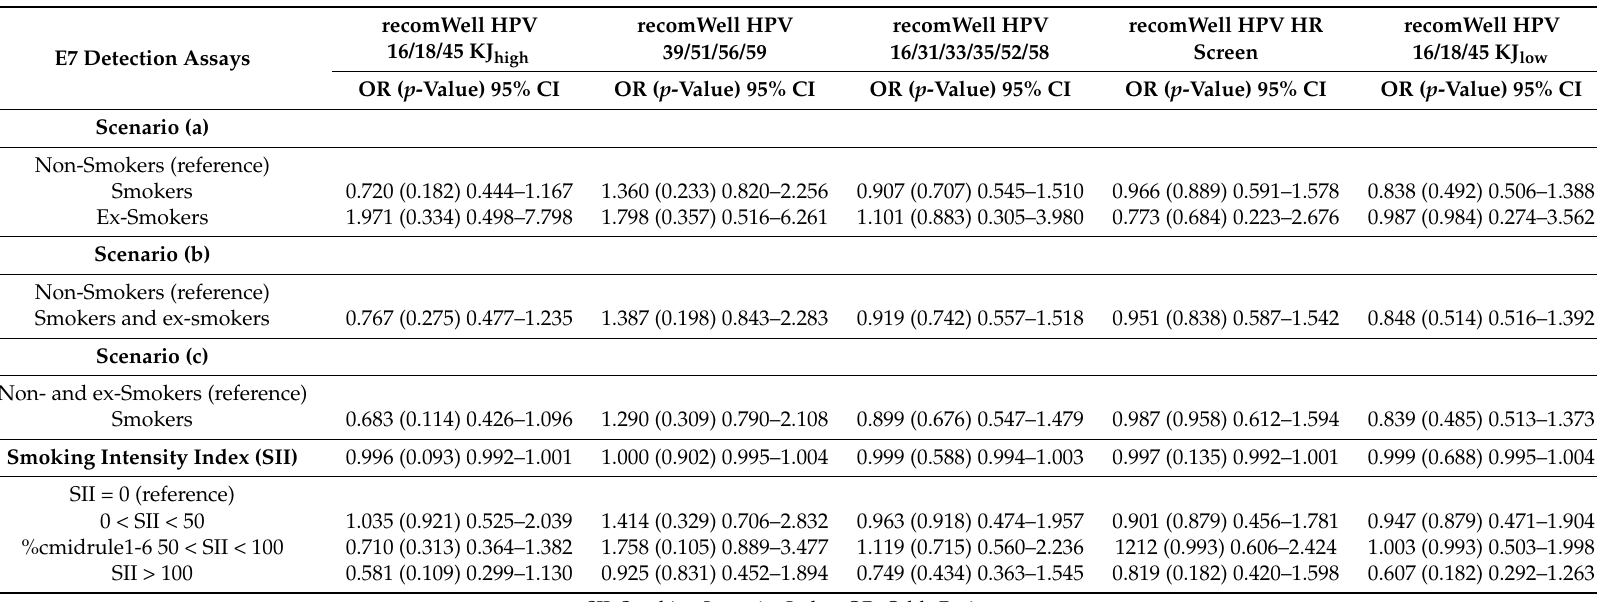
Table 4. Association between smoking/smoking intensity and E7 for hrHPV positive women. The odds ratios (95% CI) and the corresponding p -values (binary logistic regression) are displayed per horizontal panel. Cross-tabulation tables are not displayed due to space